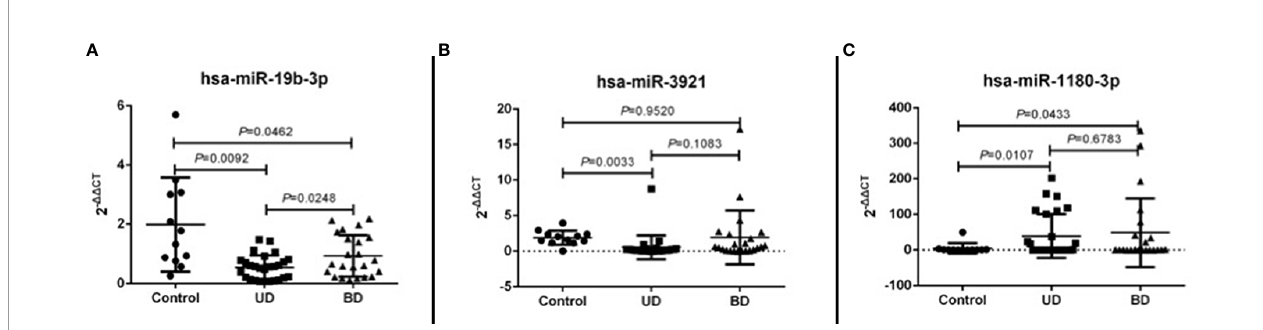
FIGURE 2 | Scatter plot fi gures show qRT-PCR validation of the differential expression of three miRNAs among three groups (unipolar patients (UD), bipolar patients (BD), and healthy controls (HC) (A) miR-19b-3p, (B) miR-3921, (C) miR-1180-3p). The values of 2- DD CT represent the expressed level of fi ltered miRNAs. A p -value of < 0.05 means statistically signi